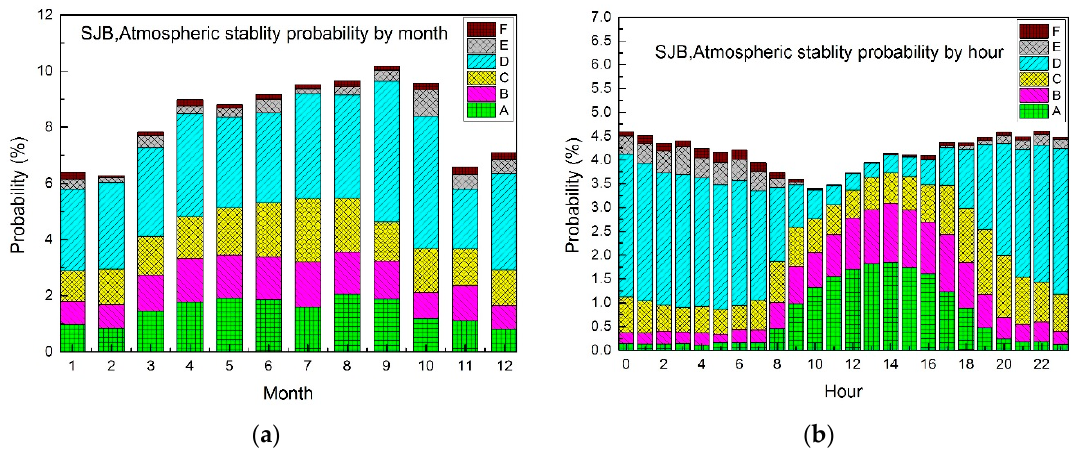
Figure 4. Probability of atmospheric stability classification at SJB: ( a ) monthly variation; ( b ) daily variation.